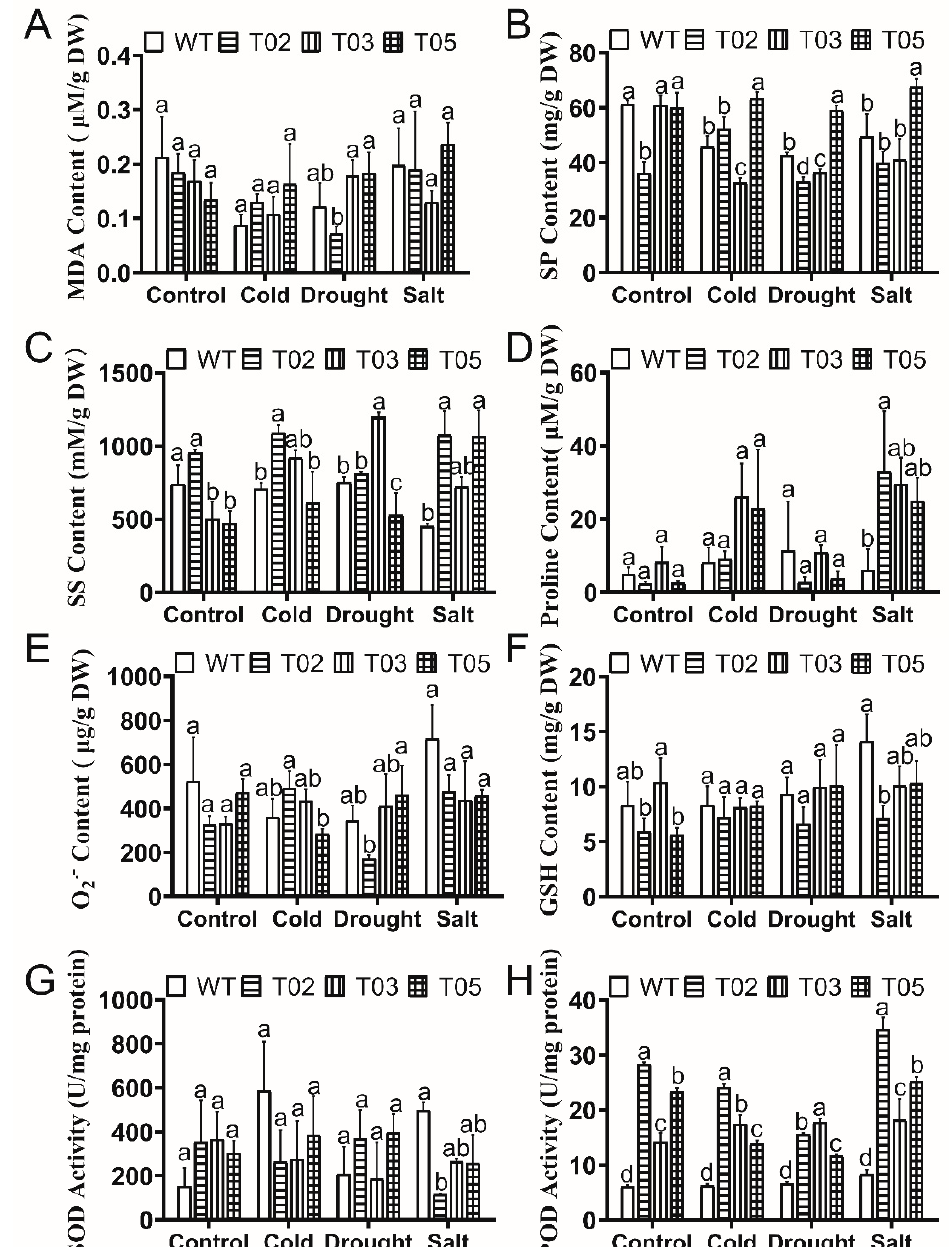
Figure 3. Physiological varieties in overexpressed MsTRX tobacco overexpressing under cold, drought, and salt treatments. ( A ) Content of malondialdehyde (MDA). ( B ) Content of soluble protein (SP). ( C ) Content of soluble sugar (SS). ( D ) Content of proline. ( E ) Content of superoxide anion (O 2. − ). ( F ) Content of reduced glutathione (GSH). ( G ) Activity of superoxide dismutase (SOD). ( H ) Activity of peroxidase (POD). WT: wild type. T02: line 2. T03: line 3. T05: line 5. The error bars represented the means ± SDs of three independent biological replicates. The different lowercase represented significant differences ( α = 0.05).